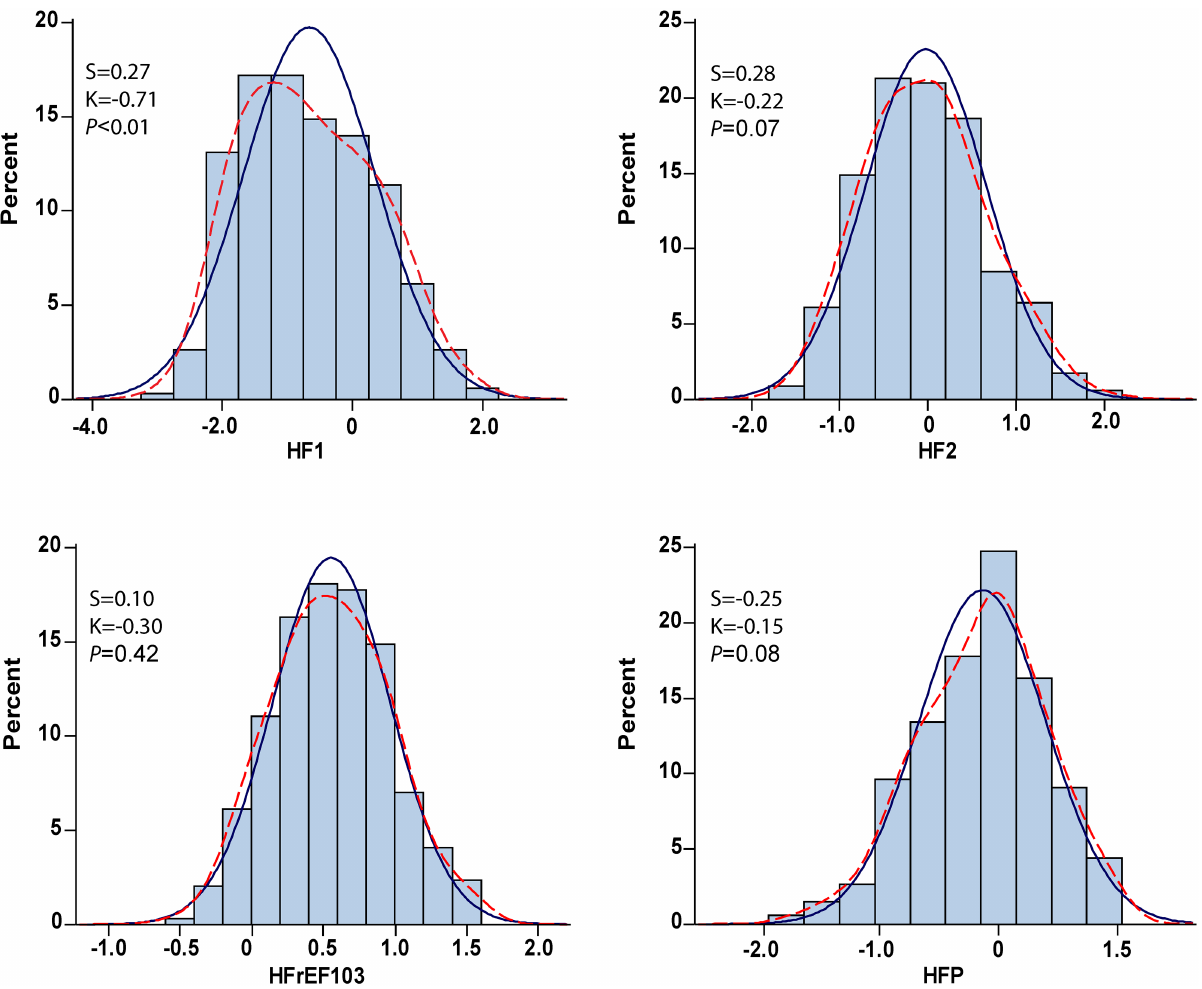
Fig 2. Distributions of the multidimensional urinary proteomic classifiers HF1, HF2, HfrEF103and HFP, consisting of 85, 671, 103 and 96 urinary peptide fragments and designed for diagnosis and prognostication in the frameworkof subclinical diastolic left ventricular dysfunction (HF1) or symptomatic heart failure (HF2, HFrEF103 and HFP). The P value is for departure of the actually observed distribution (kernel distribution;dotted line) from normality (full line).